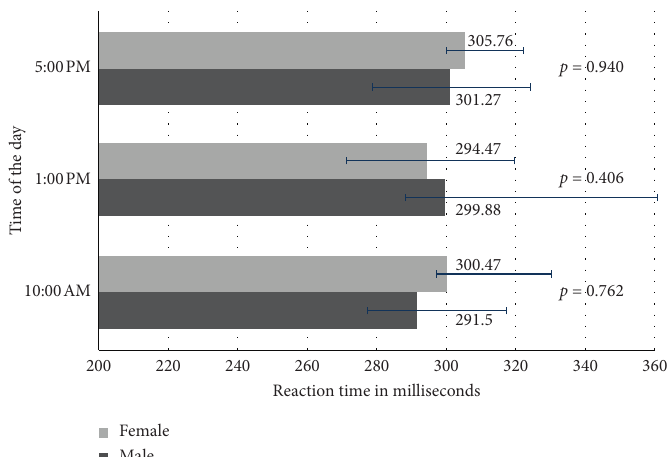
Figure 2: Comparison of the visual simple reaction time of study participants at different times of the day based on gender. The data shown are the median reaction time; the horizontal error bars represent the 25th and 75th